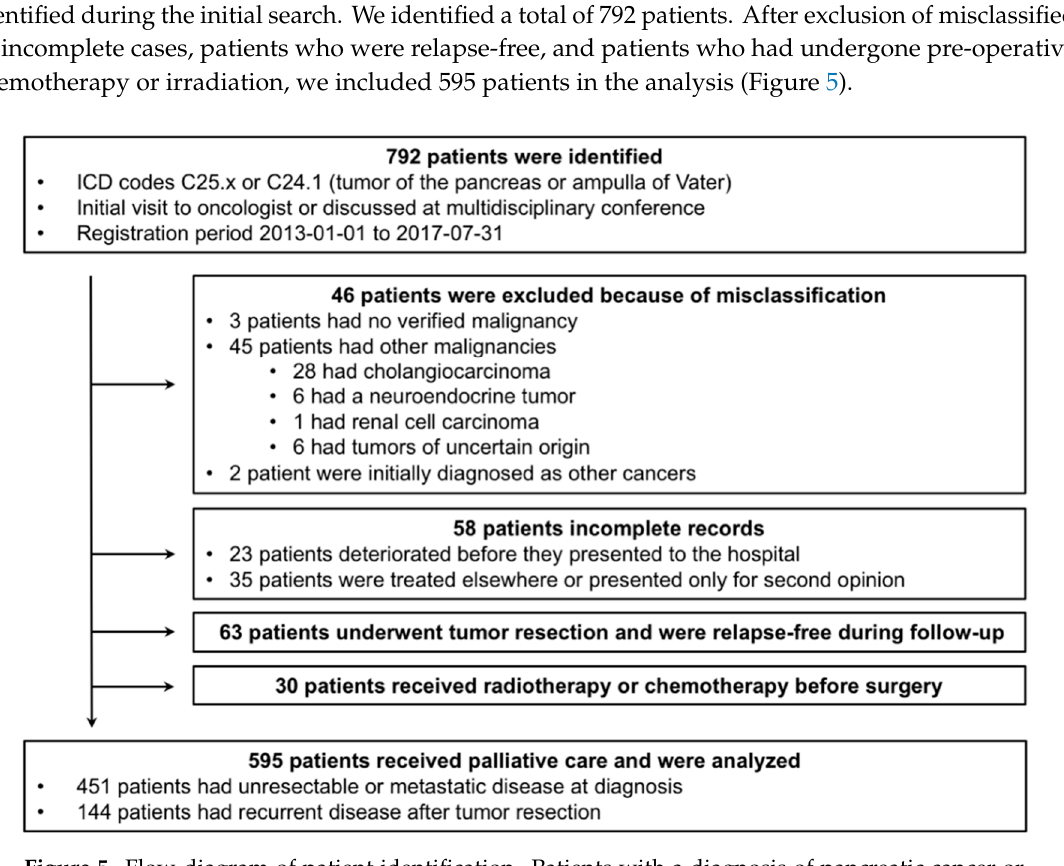
Figure 5. Flow-diagram of patient identification. Patients with a diagnosis of pancreatic cancer or periampullary cancer were selected from the electronic medical record system. Patients who had other diagnoses, who had been misclassified, who had incomplete records, or who had not received treatment for advanced or recurrent pancreatic ductal adenocarcinoma (PDAC) were excluded from the analysis.